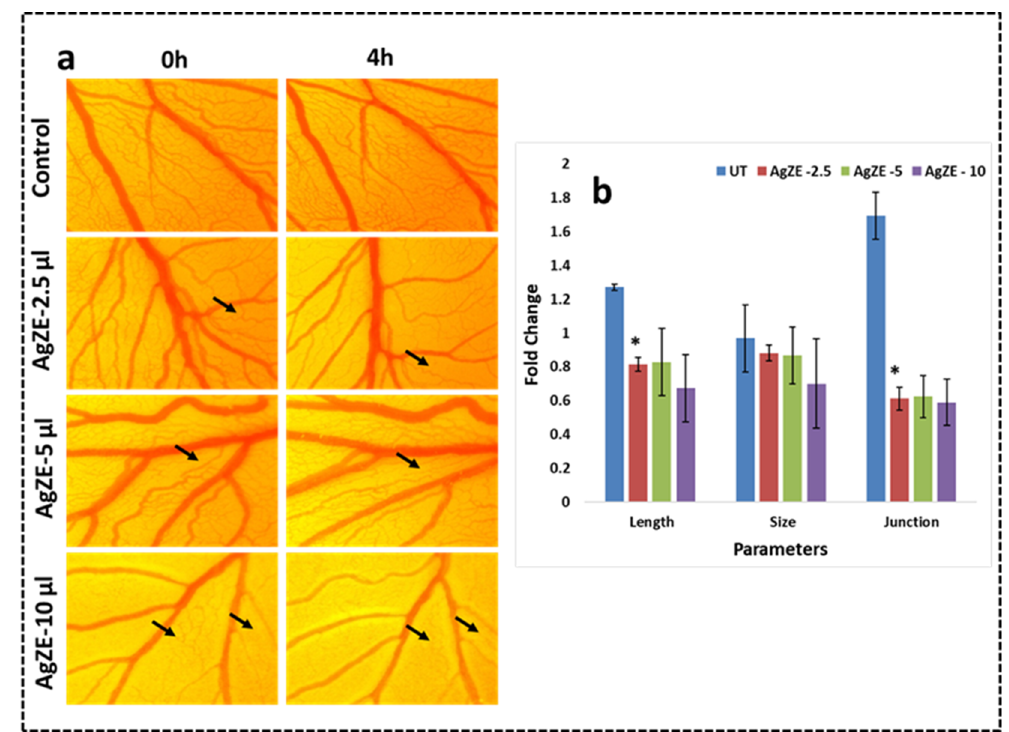
Figure 9. Chick embryo angiogenesis assay ( a ) Column I: 0 h; Column II: 4 h; Row I: Control (untreated); Row II: AgZE-2.5 µL; Row III: AgZE-5 µL; and Row IV: AgZE-10 µL. AgZE inhibits the growth of blood vessels that indicate the probable anticancer nature of the nanoparticles. ( b ) The images are quantified with respect to length, junction, and size using Angioquant software. The black arrows indicate the change in blood vessels of the AgZE treatment groups at 0 h and 4 h time points. These experiments are performed thrice and represented as the mean ± SD. Significant differences from UT embryo are observed (* p < 0.05).